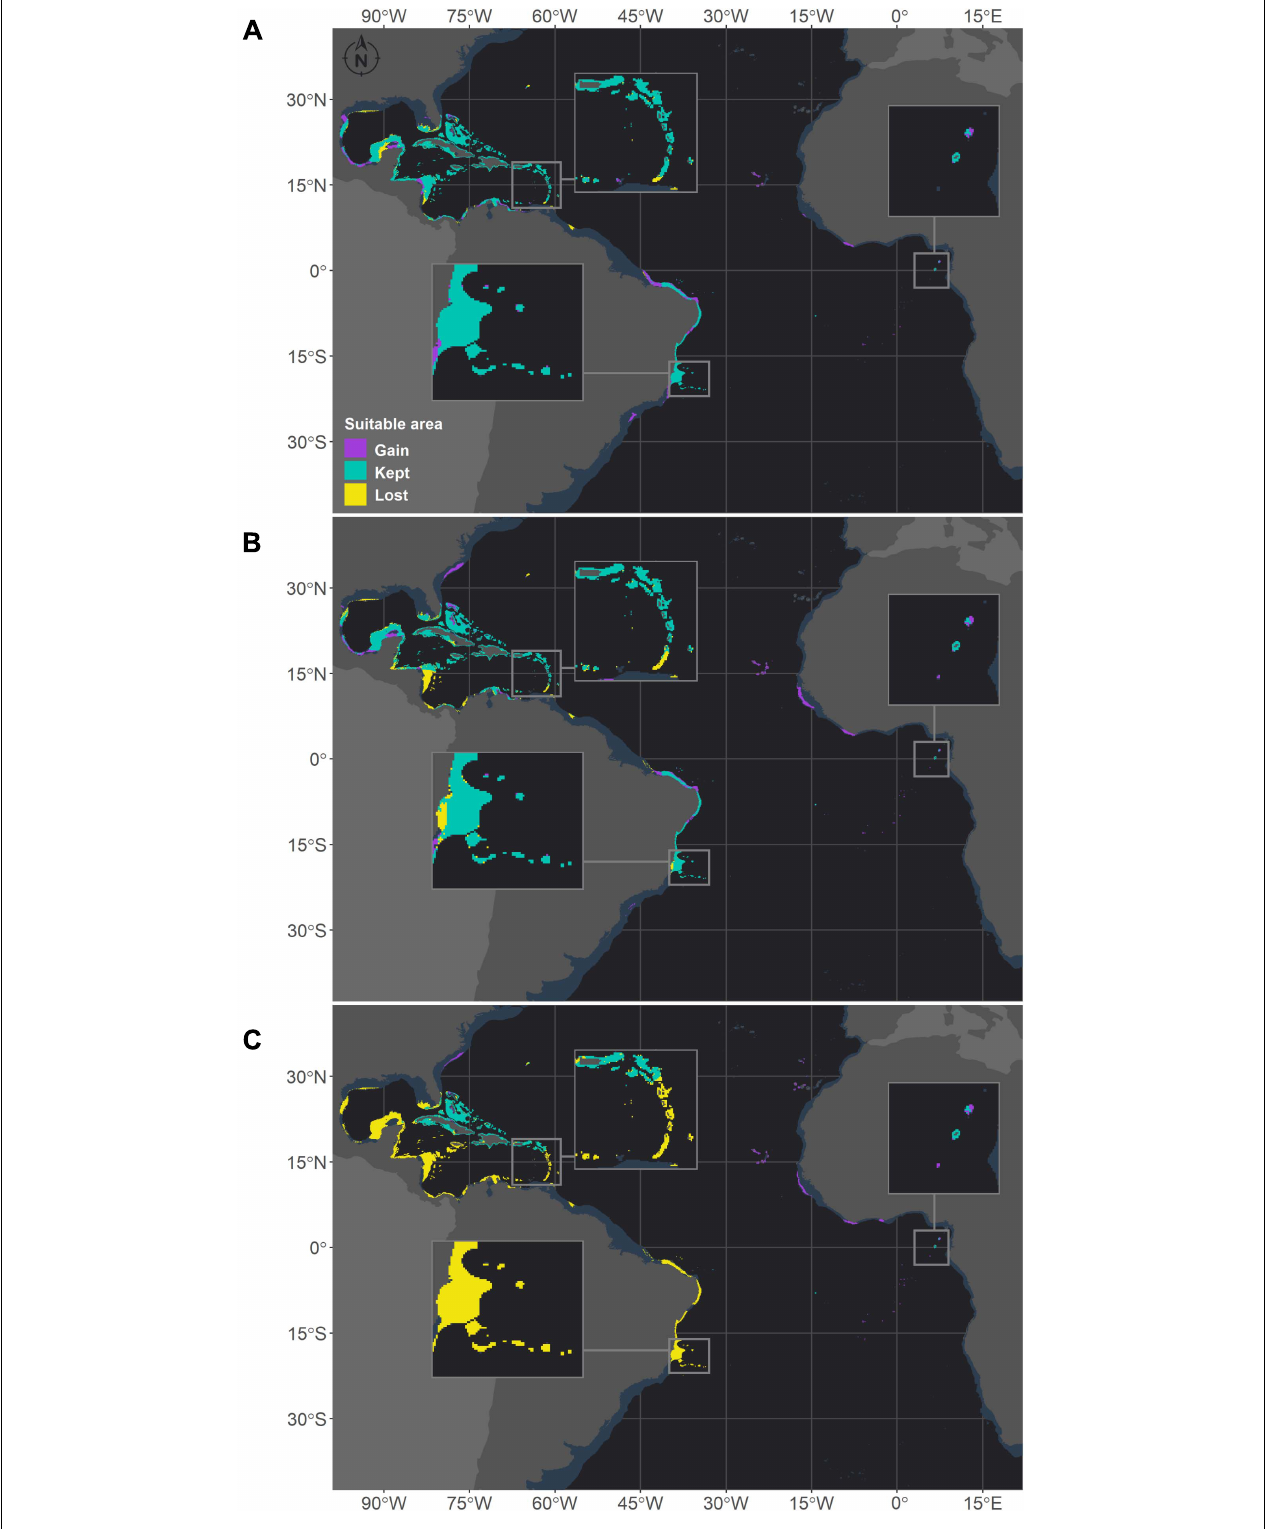
FIGURE 5 | Projected habitat suitability for future relative concentration pathway (RCP) scenarios for Montastraea cavernosa in the Atlantic obtained through an ensemble modeling approach. Models were trained on present-day data of the species and projected for the (A) RCP2.6, (B) RCP4.5, and (C) RCP8.5 scenarios. Inset maps highlight the changes in the Caribbean region (top left), São Tomé islands (right) and in the Abrolhos region (bottom).